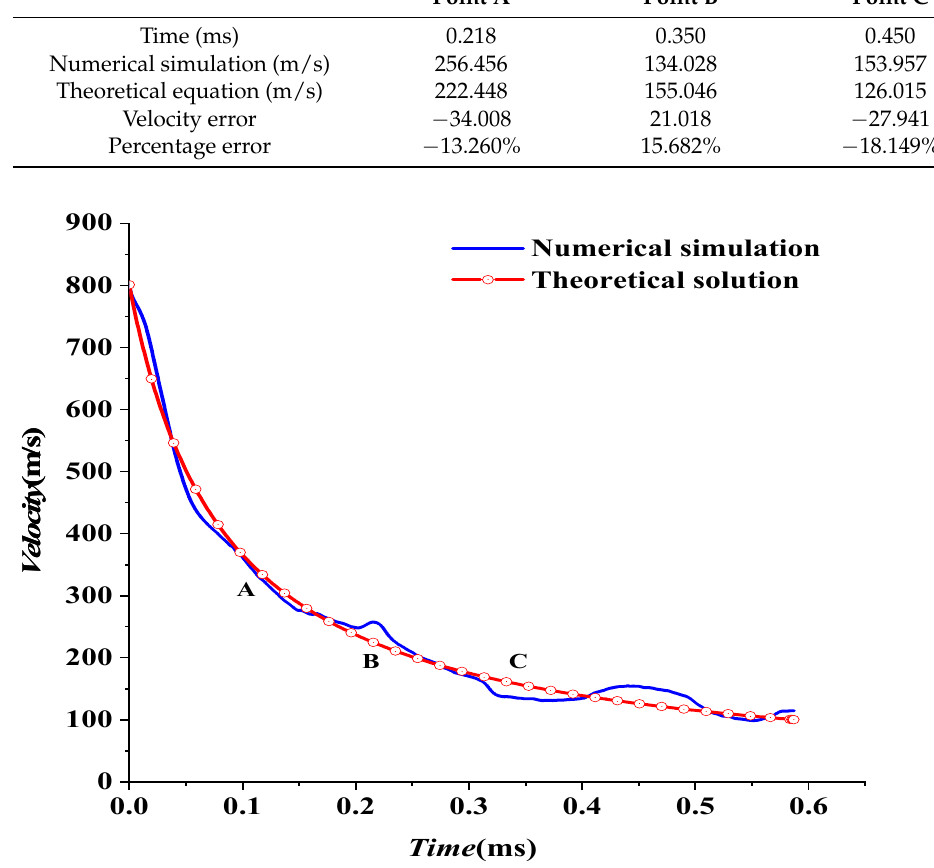
Figure 15. The fitting curve of underwater velocity attenuation of the EFP at the third